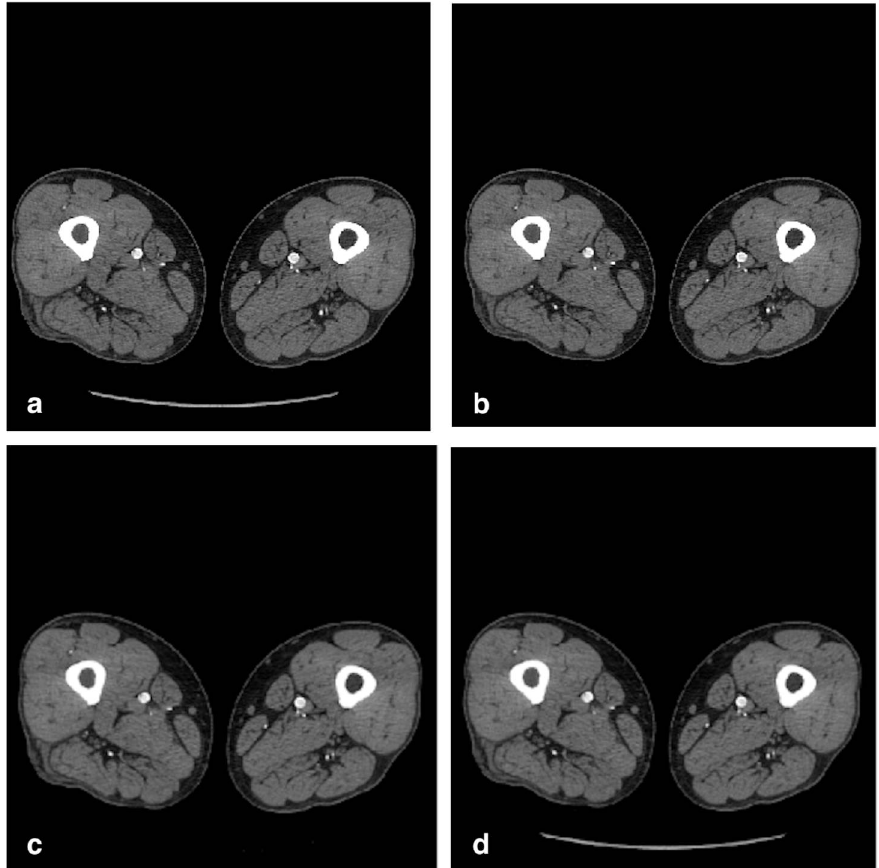
Figure 3. Image quality comparison with three different compression methods: ( a ) original image, slice 500, 512 × 512 (DICOM-16bit); ( b ) proposed method with variable bit rate (MVAR); ( c ) proposed method with fixed bit rate (MFIX); ( d ) lossy JPEG2000 without ROI image.